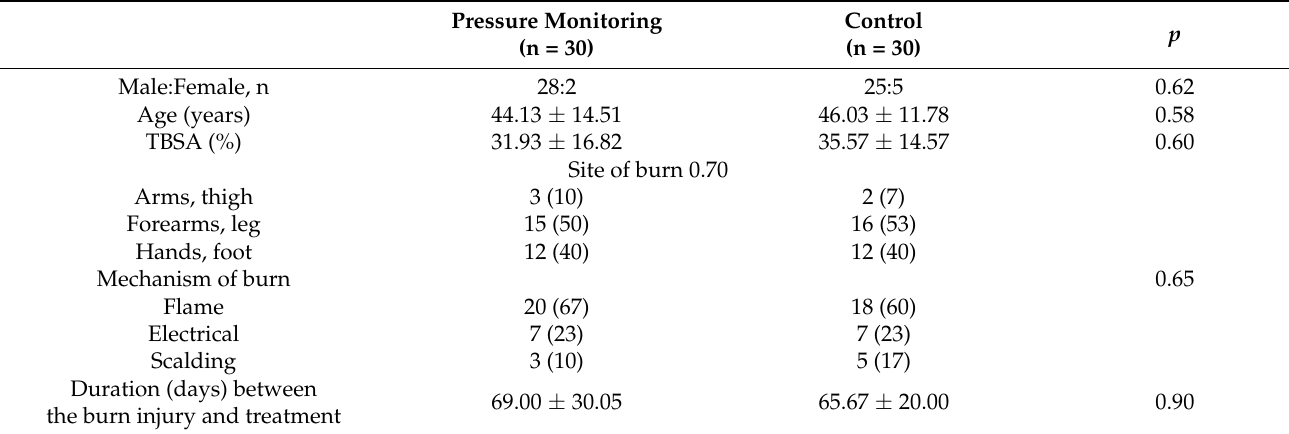
Table 1. Demographic characteristics of participants (n = 60).